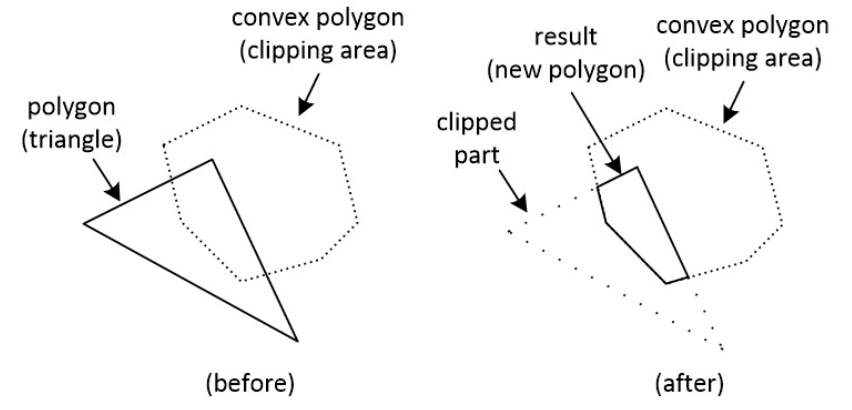
Figure 28. Clipping a polygon (triangle) against a polygon. The result is a new polygon.